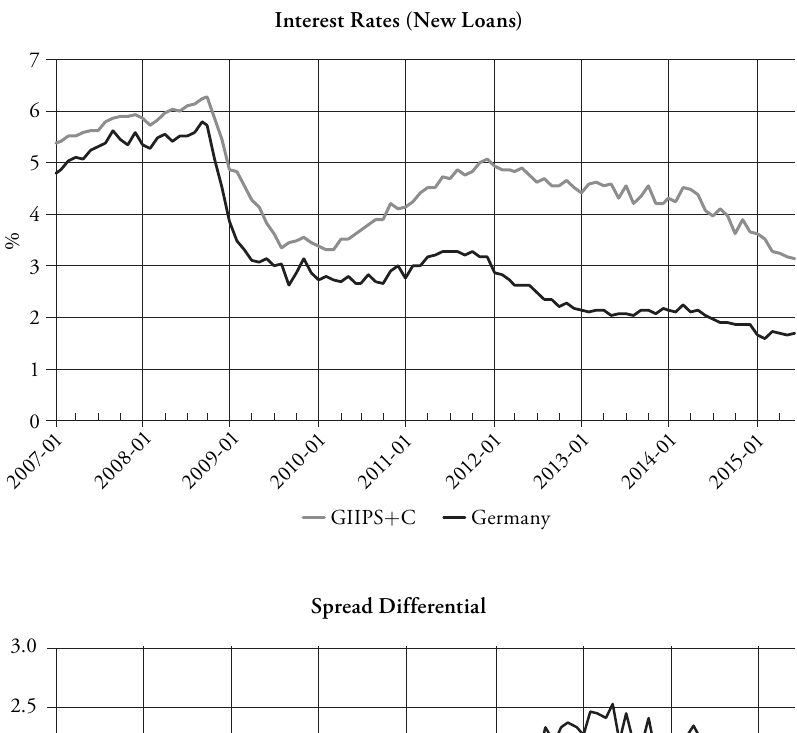
Figure 3: Loan Spread